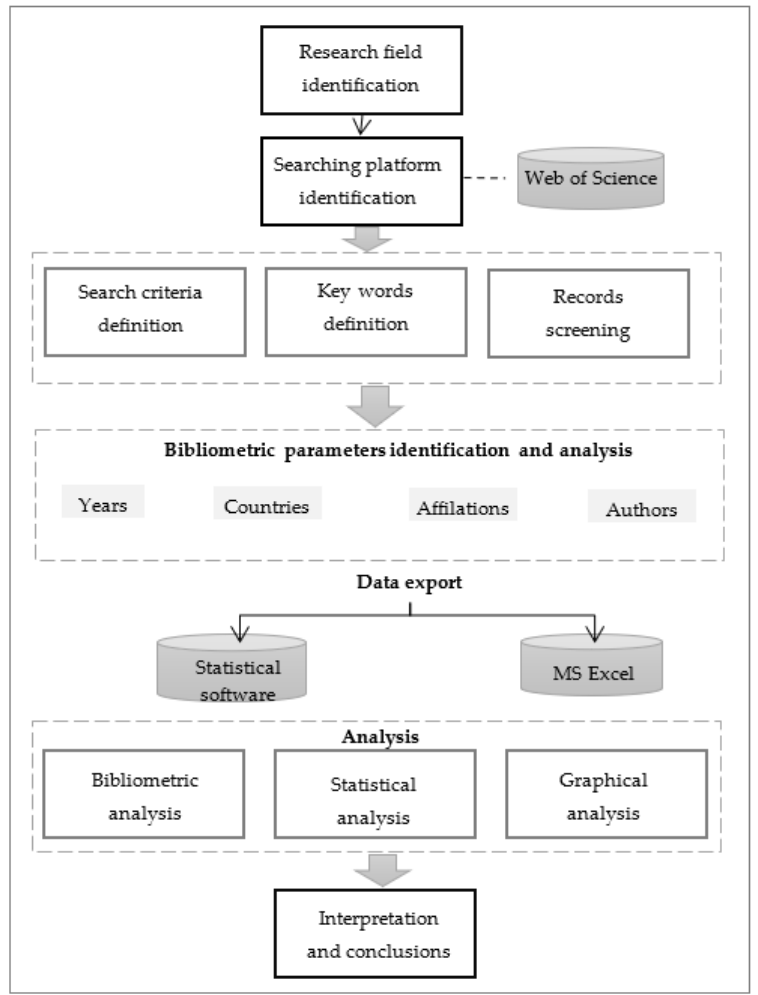
Figure 1. The methodological framework of publication